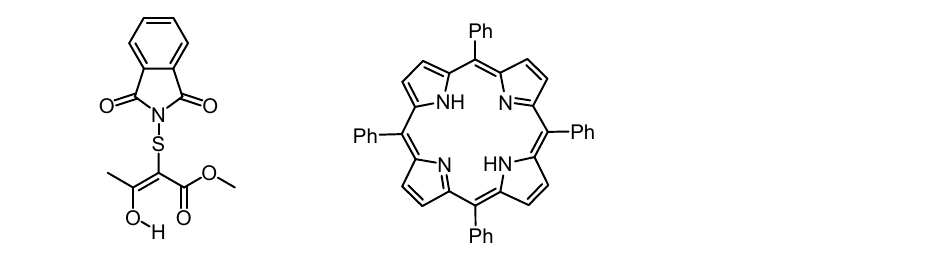
Figure 1. Representation of the structures of the heterodiene precursor ( left ) and a meso -tetraphenylporphyrin ( right ).